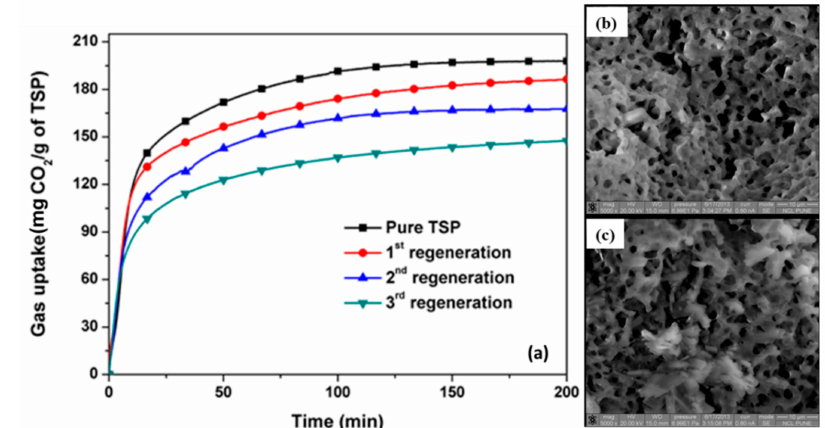
Figure 8. ( a ) CO 2 capture capacity of TSP at di ff erent regeneration levels at 30 ◦ C and 3.5 MPa pressure (Curves provided to guide the eye) SEM images of ( b ) CO 2 -loaded pure TSP and ( c ) CO 2 -loaded regenerated